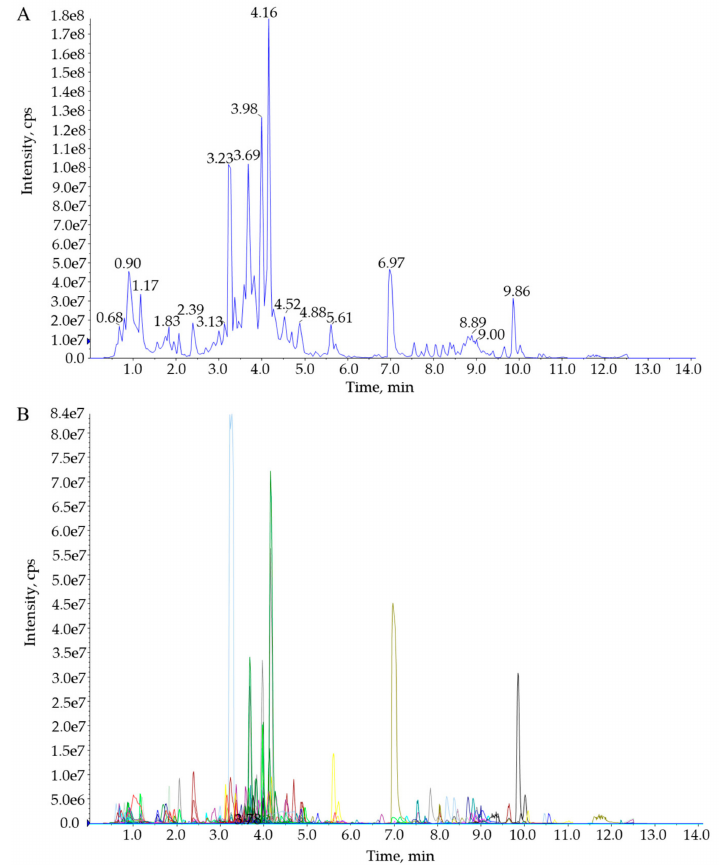
Figure 1. Total ion current of one quality control sample by mass spectrometry detection ( A ) and multi-peak detection plot of metabolites in the multiple reaction monitoring mode ( B